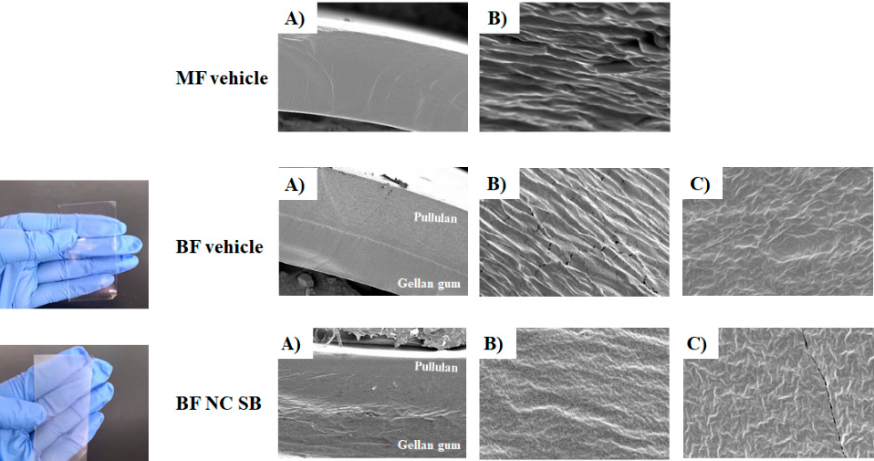
Figure 1. Macroscopic appearance and comparative SEM images of the side sections of monolayer vehicle film (MF vehicle), bilayer vehicle film (BF vehicle) and bilayer film containing silibinin-loaded nanocapsules (BF NC SB) with magnification of 300× ( A ) and magnification of 5000× on the gellan layer ( B ) and pullulan layer ( C ). Table 1. Results of bilayer films characterization.